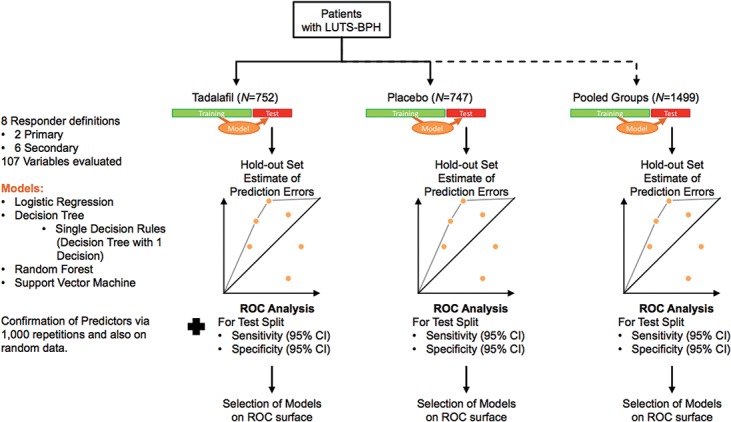
Data Analysis Flow.